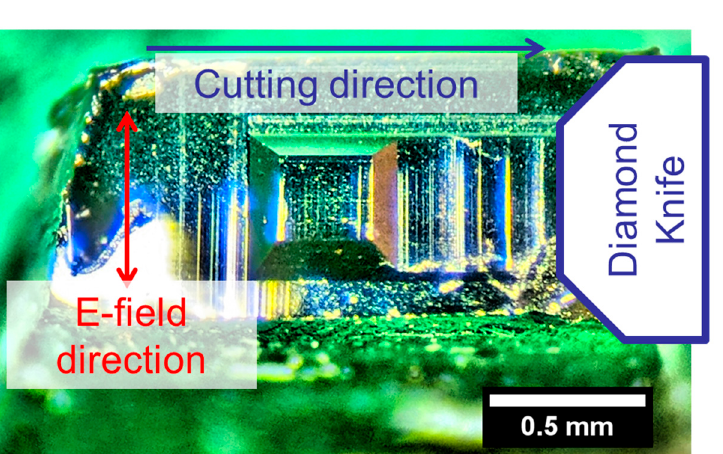
Figure A1. Determination of electric field direction based on sample orientation during cryomicrotomy. Cryomicrotomy was performed such that the diamond knife’s cutting edge was parallel to the electric field direction. Knife marks were perpendicular to the field direction, and sample chattering patterns were parallel to the field direction.